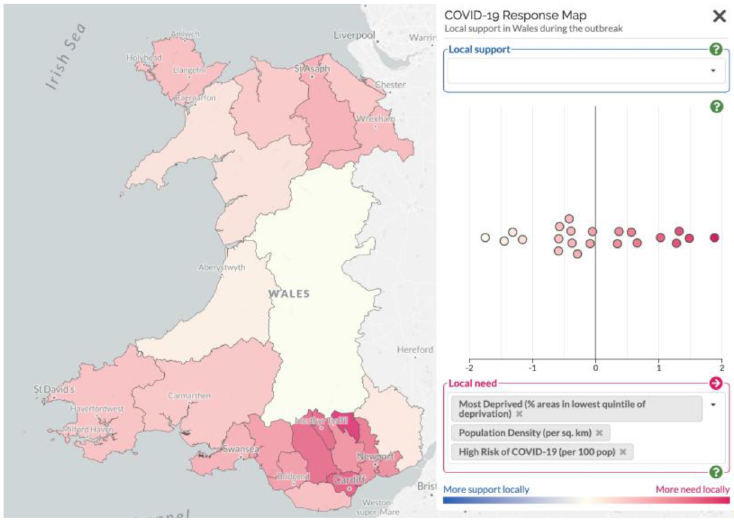
Figure 4: Illustration of mapping a composite need score using the number of people at high risk, population density and deprivation